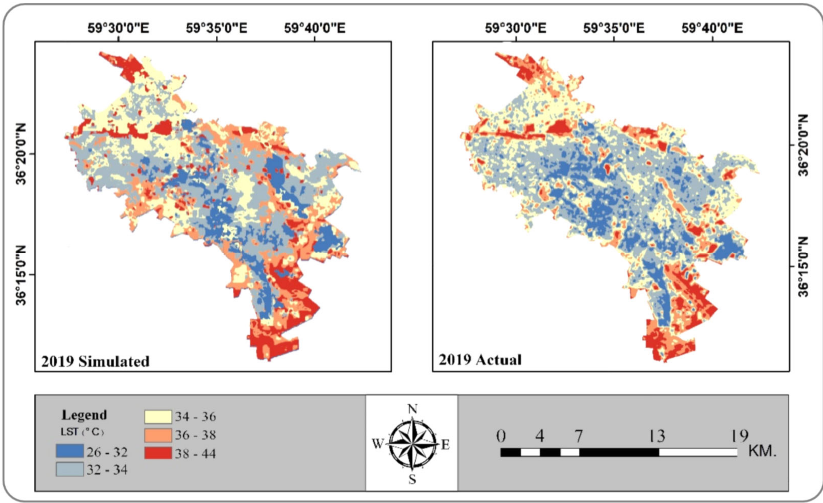
Figure 9. The simulated ( left panel) and actual ( right panel) Mashhad city LST maps for 2019.